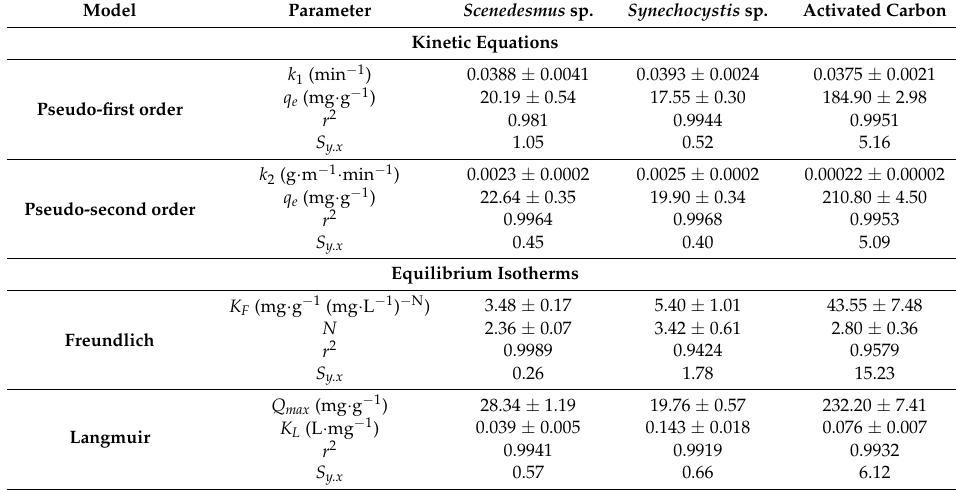
Table 1. Parameters from the experimental results fittings to the kinetic (pseudo-first order kinetic equation and pseudo-second order equation) and equilibrium isotherm (Langmuir and Freundlich equilibrium isotherms) models considered.